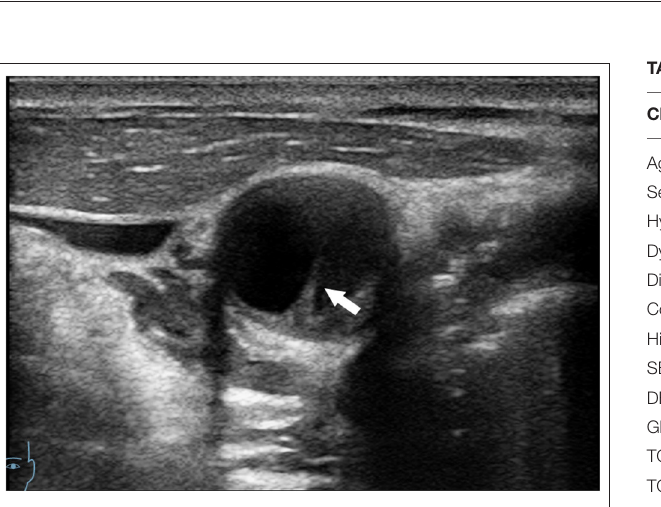
FIGURE 2 | Conventional ultrasound showing axial view of CaW (arrow indicates shelf-like CaW).